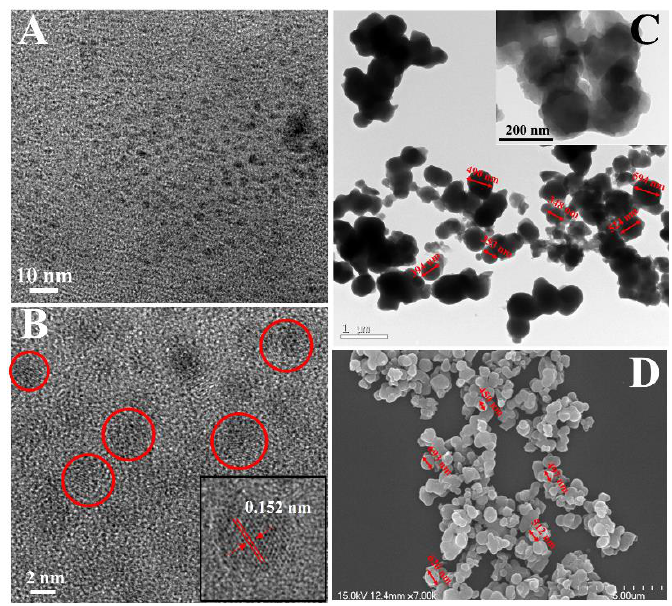
Figure 2. ( A , B ) TEM images of GQDs (inset: HRTEM image of GQDs), ( C ) TEM images and ( D ) SEM image of GQDs@SMIP.